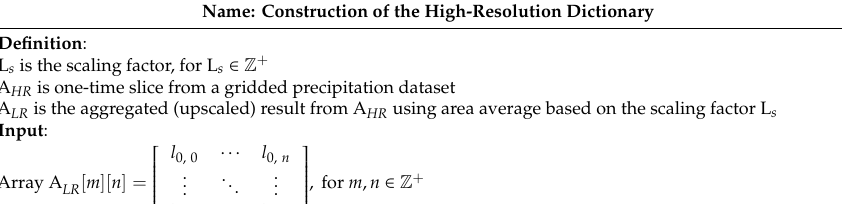
Table 2. The dictionary construction algorithm.